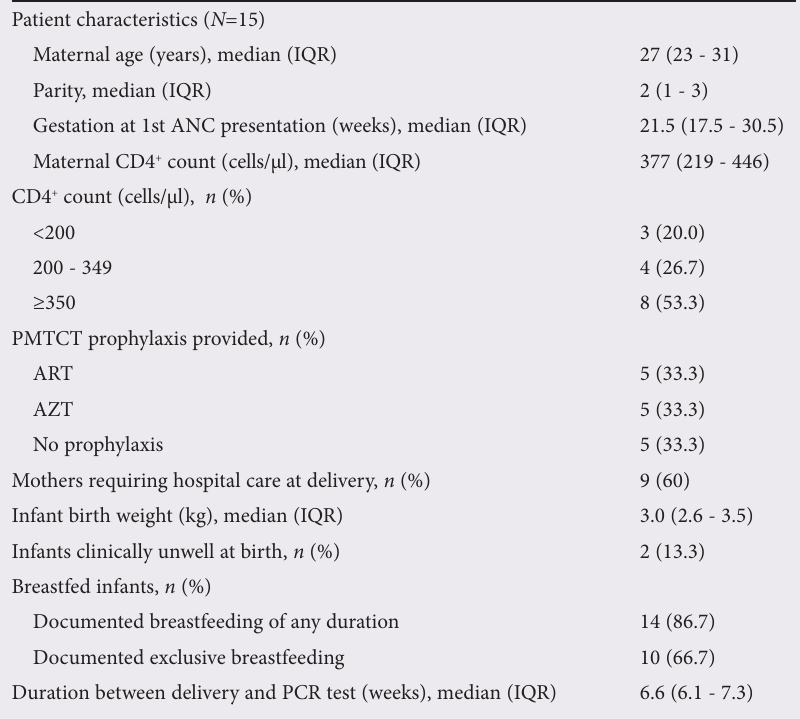
Table 1. Clinical and demographic features of mother-infant pairs where transmission of HIV occurred Patient characteristics ( N